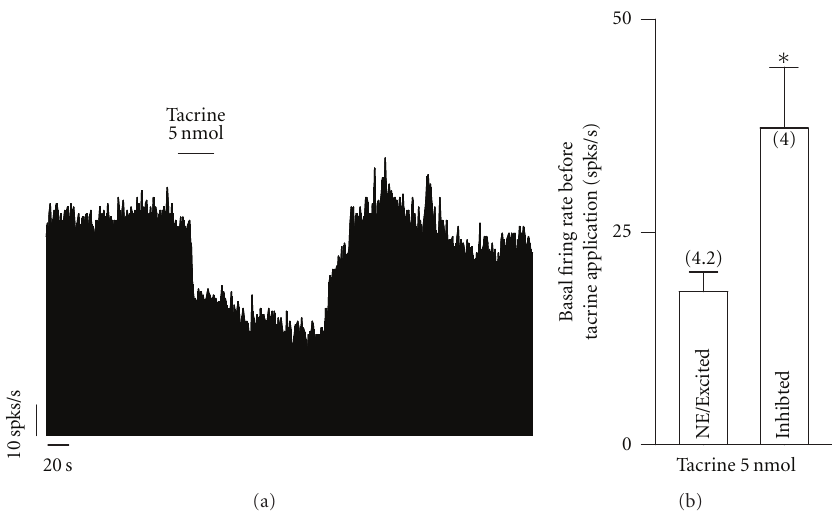
Figure 4: The increase in the tonic cholinergic input modifies the firing rate in globus pallidus neurons depending on the baseline firing rate before application of tacrine. (a) Frequency histogram showing the firing rate inhibition induced by local application of 5 nmol tacrine in a globus pallidus neuron firing at ∼ 75 spikes/s. (b) Statistics illustrating that the e ff ect of the local blockade of acetylcholinesterase in the spiking rate depends on the baseline firing rate before local infusion of 5nmol tacrine ( ∗ P < 0 . 01; t -test). spks/s, spikes per second; NE/Excited, no e ff ect or